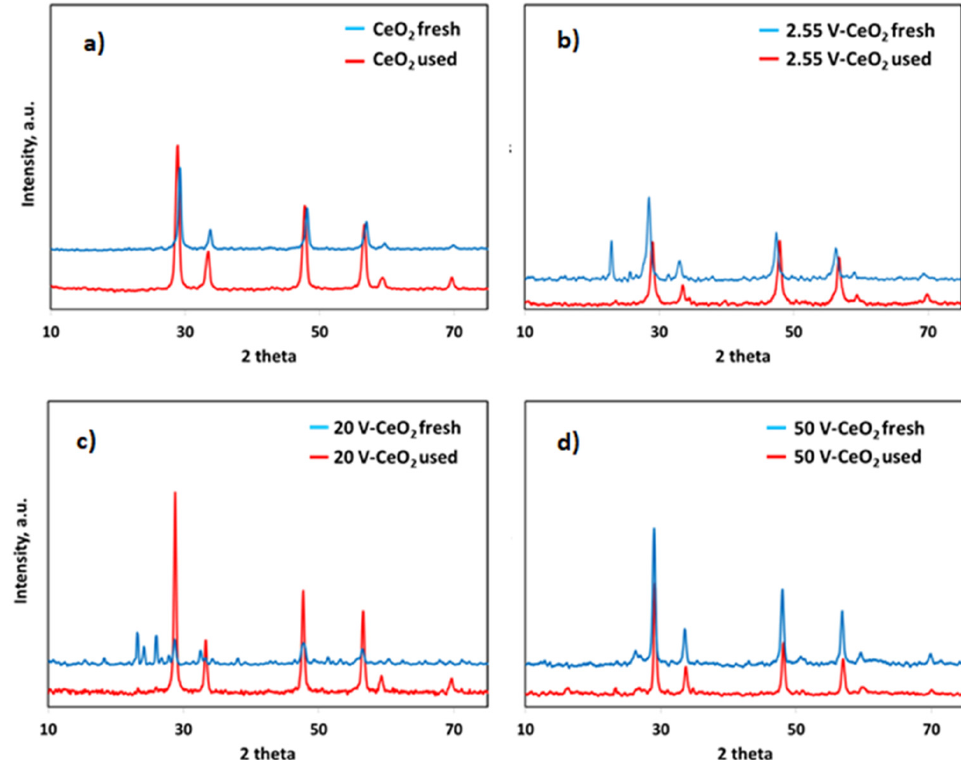
Figure 10. XRD spectra of fresh and used catalysts: CeO 2 ( a ), 2.55 V-CeO 2 ( b ), 20 V-CeO 2 ( c ), 50 V-CeO 2 ( d ).